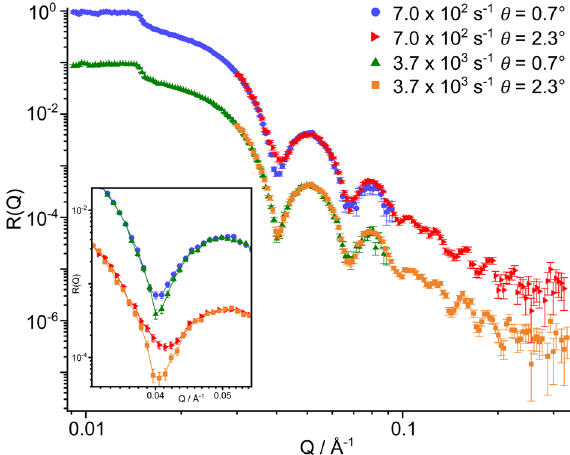
Figure 4. NR data for dodecane- d 26 entrained against an iron-coated silicon substrate at 7.0 × 10 2 s − 1 and 3.7 × 10 3 s − 1 . The data collected at 3.7 × 10 3 s − 1 are offset by 10 − 1 in the vertical axis. The insert compares the two shear rates for each angle, where the data collected at θ = 2.3 ◦ are offset by 10 − 1 in the vertical axis. The lines between data points in the insert are linear interpolation lines to guide the